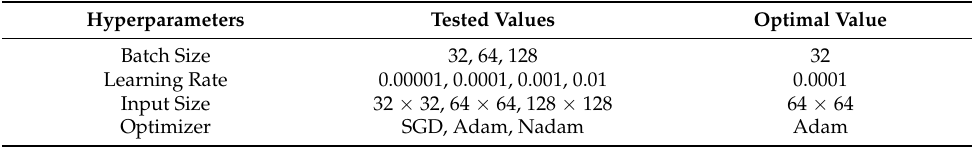
Table 6. Summary of optimal hyperparameters for the proposed Gait-ViT method.